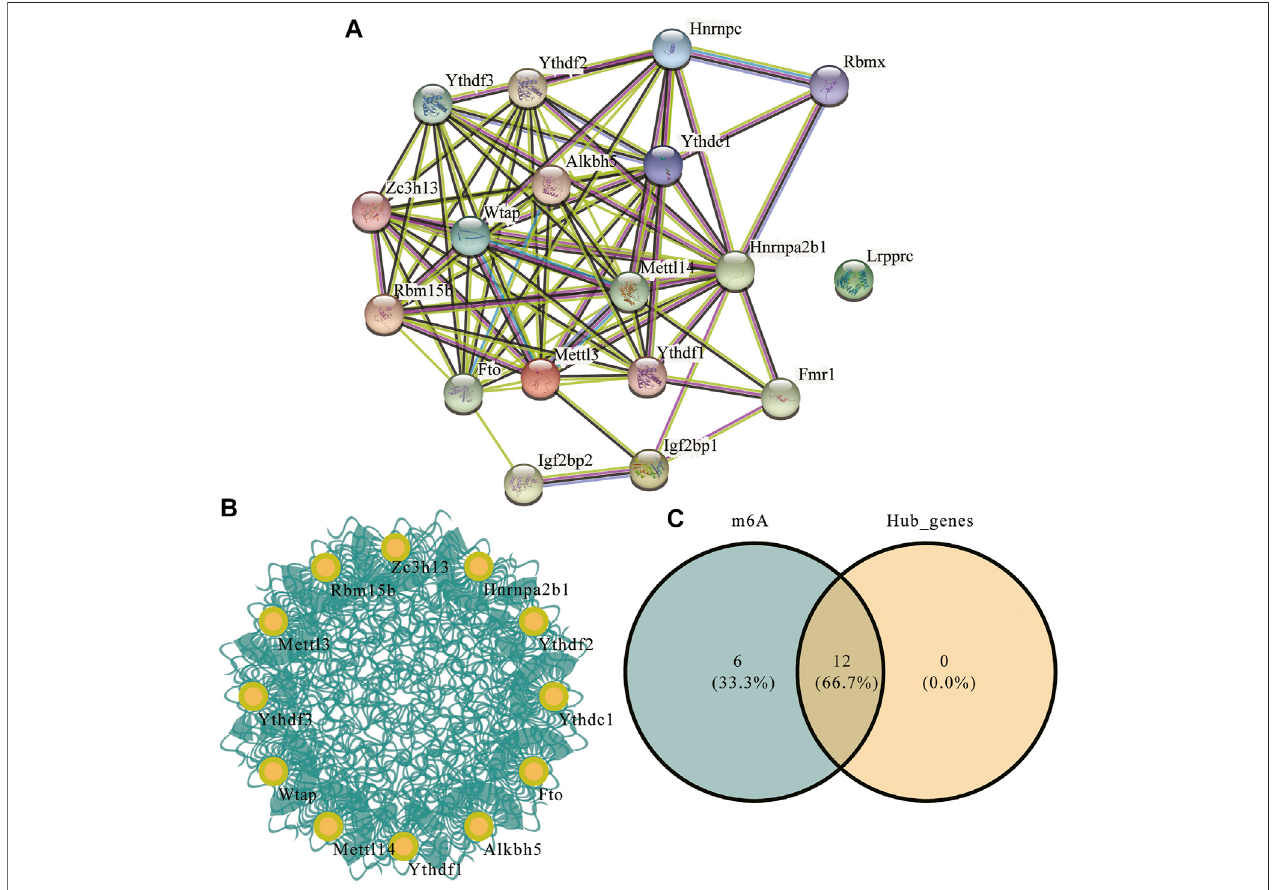
FIGURE 8 | m6A regulator protein-protein interaction (PPI) network. (A) PPI network of the m6A regulators; the number of edges indicate the credibility of the evidence. (B) Network diagram of hub genes. (C) Venn diagram of hub genes and m6A regulators.